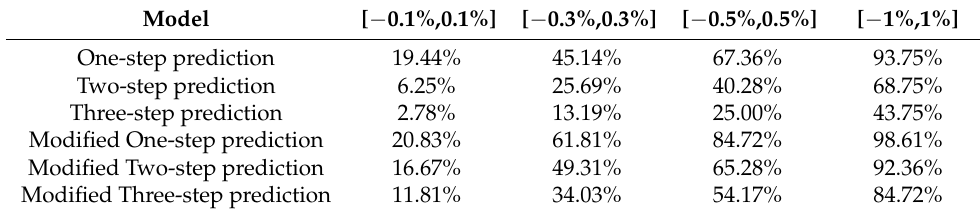
Table 6. Error interval evaluation of prediction